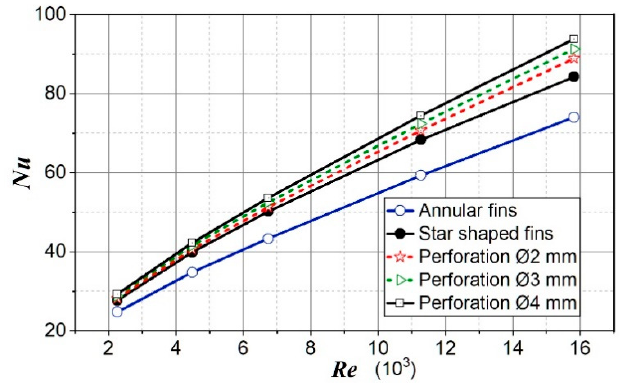
Figure 10. Nusselt number for analyzed cases.